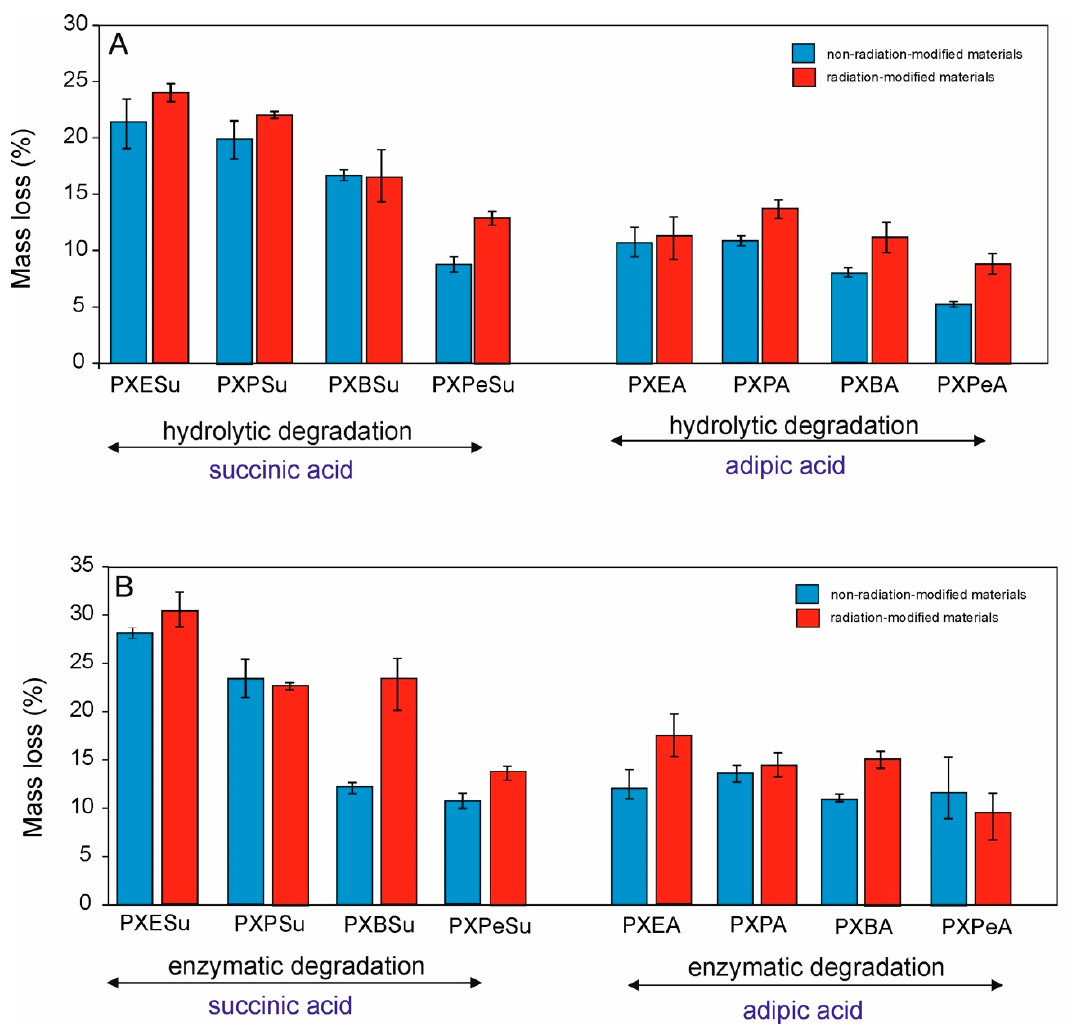
Figure 14. Hydrolytic ( A ) and enzymatic degradation ( B ) of PXESu, PXPSu, PXBSu, PXPeSu and PXEA, PXPA, PXBA, and PXPeA nonradiation-modified materials (blue) and radiation-modified materials (red).